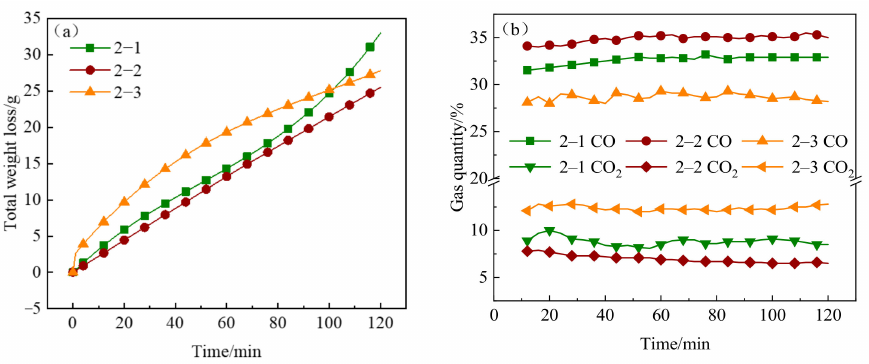
Figure 2. Weight loss in the second group experiment and corresponding gas compositions. ( a ) Total weight loss curve during experiment; ( b ) gas compositions emitted during experiment.